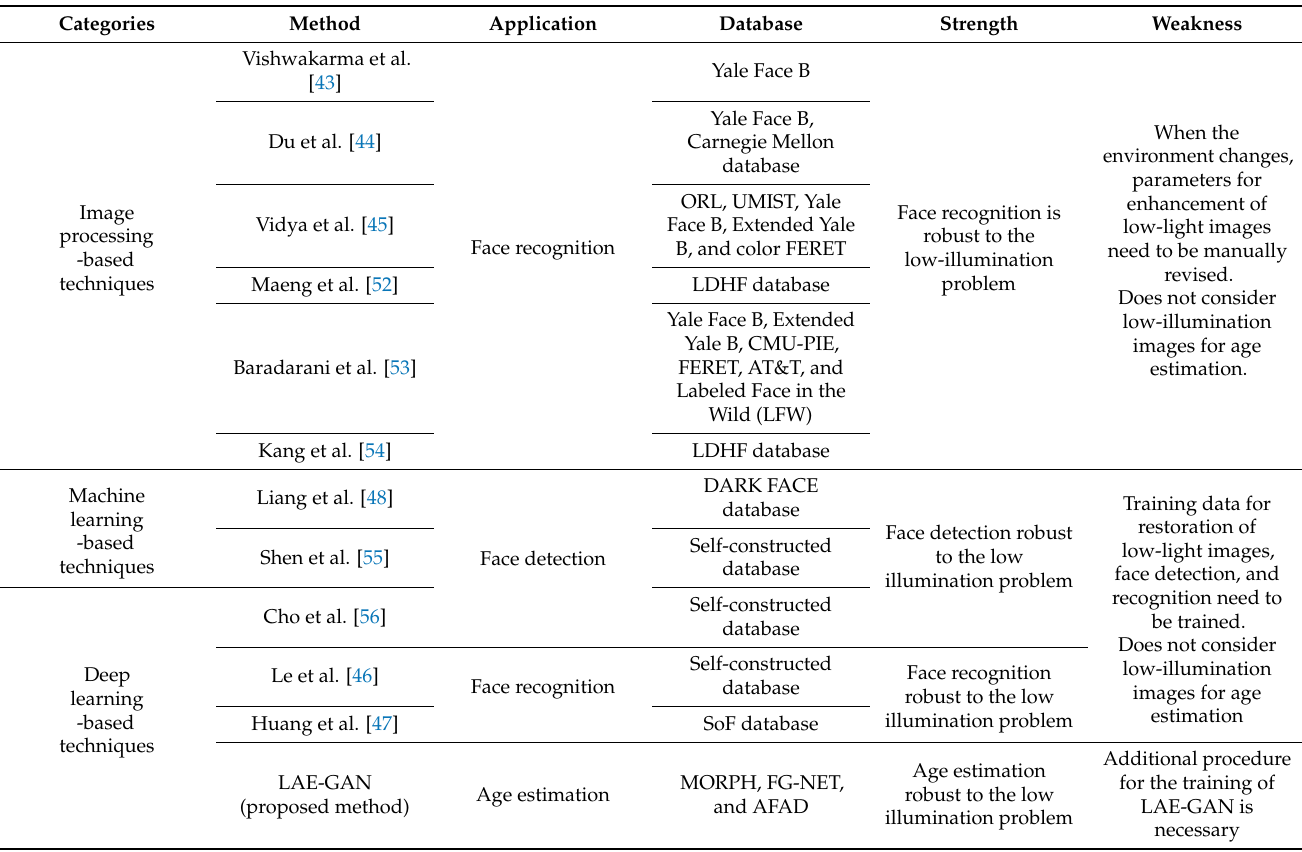
Table 2. Comparisons between the proposed method and previous studies in which low-light facial images were enhanced.